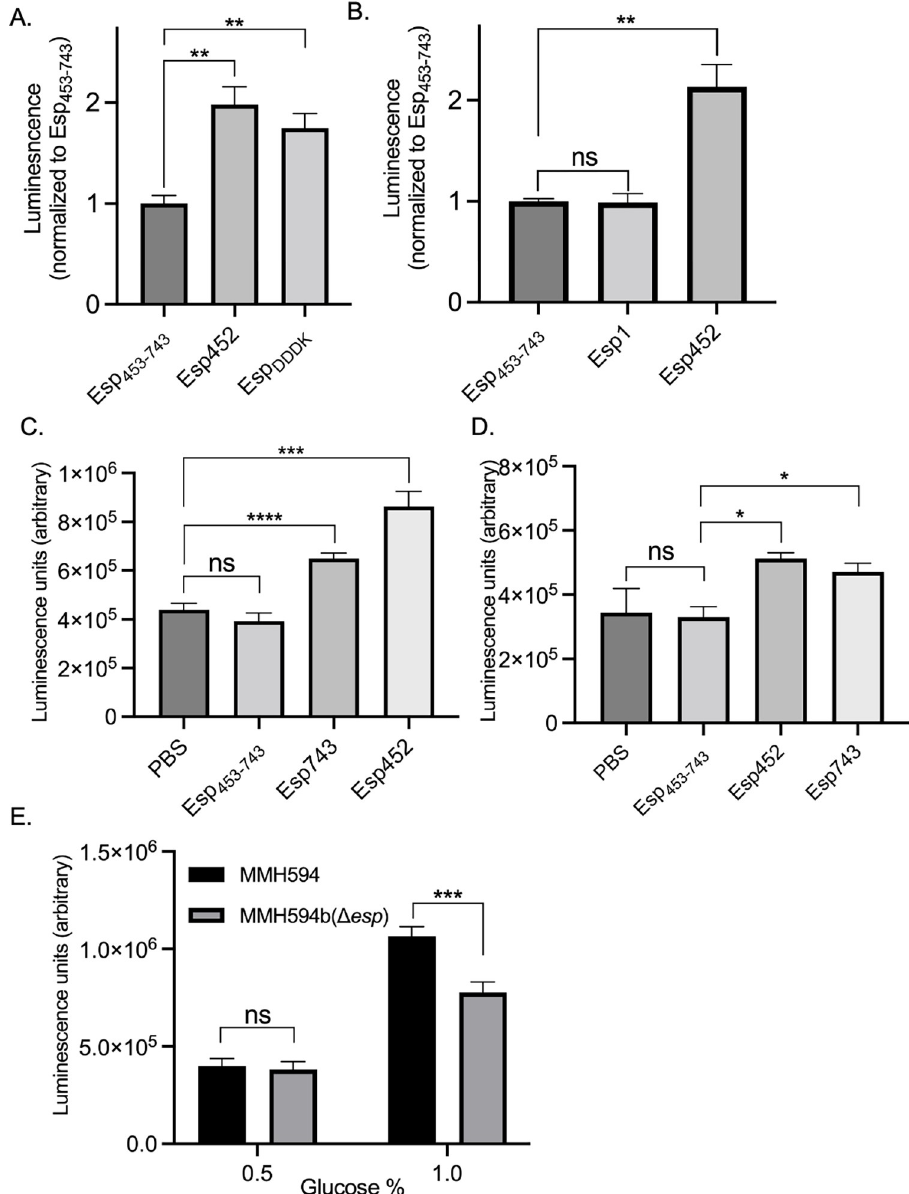
Fig 6. Biofilm Strengthening by Esp DDDK and Esp743. A. Luminescence of MMH594b ( Δ esp ) biofilms grown with Esp 453-743 , Esp452, or Esp DDDK . Luminescence values were divided by the average luminescence of biofilms grown with Esp 453-743 . The experiment was performed in triplicate in three independent experiments. Samples were compared by Welch’s ANOVA with D3 Dunnett’s post-hoc test. �� , p < 0.01. B. Luminescence of MMH594b ( Δ esp ) biofilms grown with Esp 453-743 , Esp452, or Esp1. All luminescence values were divided by the average luminescence of biofilms grown with Esp 453-743 . The experiment was performed in duplicate or triplicate in three independent experiments. Samples were compared by Welch’s ANOVA with D3 Dunnett’s post-hoc test. �� , p < 0.01. C. Luminescence of FA2-2 biofilms grown overnight with PBS, Esp 453-743 , Esp743, or Esp452. The experiment was conducted with duplicates or triplicates in two or more independent experiments, with n ranging from 5 to 15. The SEM is indicated with error bars. Samples were compared by Welch’s ANOVA and D3 Dunnet’s post hoc test. p < 0.001, ��� ; p < 0.0001, ���� . D. Luminescence of OG1RF biofilms grown with PBS, Esp 453-743 , Esp452, or Esp743. The experiment was conducted with triplicates. Samples were compared by Welch’s ANOVA with D3 Dunnett’s post- hoc test. � p < 0.05. E. Luminescence of MMH594 and MMH594b ( Δ esp ) biofilms grown in media supplemented with either 0.5 or 1.0% glucose. The experiment was performed in triplicate in three independent experiments. Samples were compared by 2-Way ANOVA with Tukey’s post-hoc test. ��� , p <